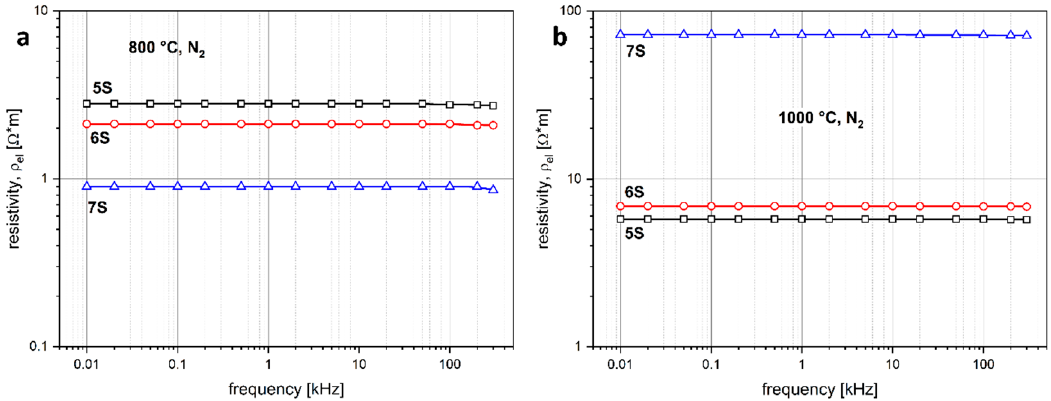
Figure 4. Electrical resistivity of FA/glass samples fired in nitrogen at 800 °C ( a ) and 1000 °C ( b ).